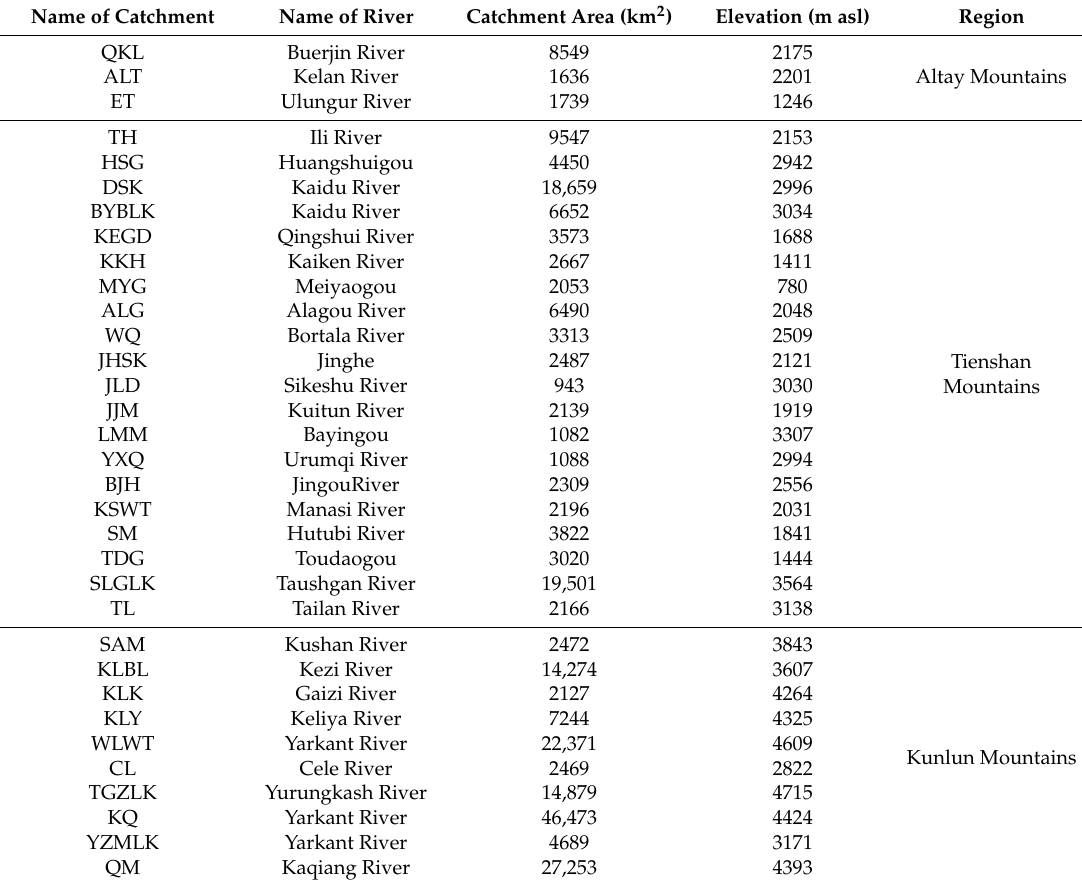
Table 1. Information of 33 gauging stations in the study